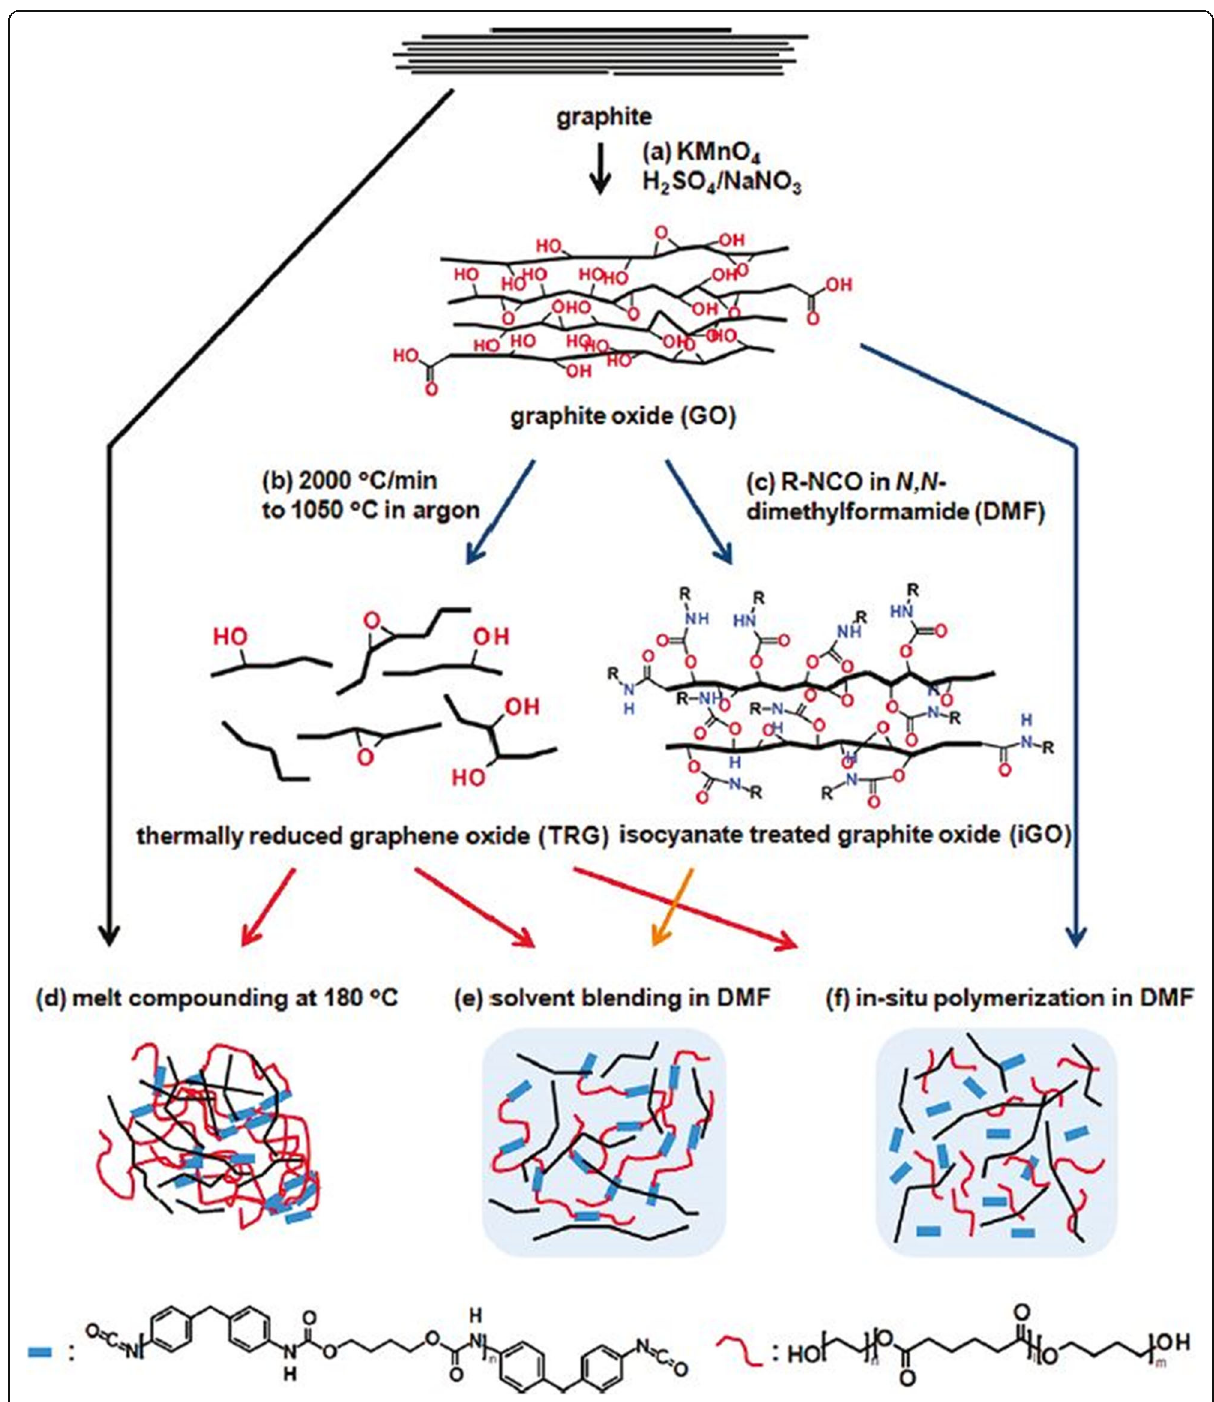
Fig. 6 Schematic representation of TPU/Graphene Composite Preparation: a After oxidation of graphite functionalized layers of graphene can be obtained by ( b ) Rapid Thermal Expansion or ( c ) Organic Modification with Isocyanate in dimethylformamide (DMF) (iGO); ( d ) Graphite can be mixed with TPU via Melt mixing, or ( e ) Solvent mixing, followed by solvent removal; ( f ) In opposite, composites can be produced monomers using In situ polymerization. Black lines represent graphitic reinforcements. TPU hard and soft segments are represented by short blue blocks and thin red curves, respectively